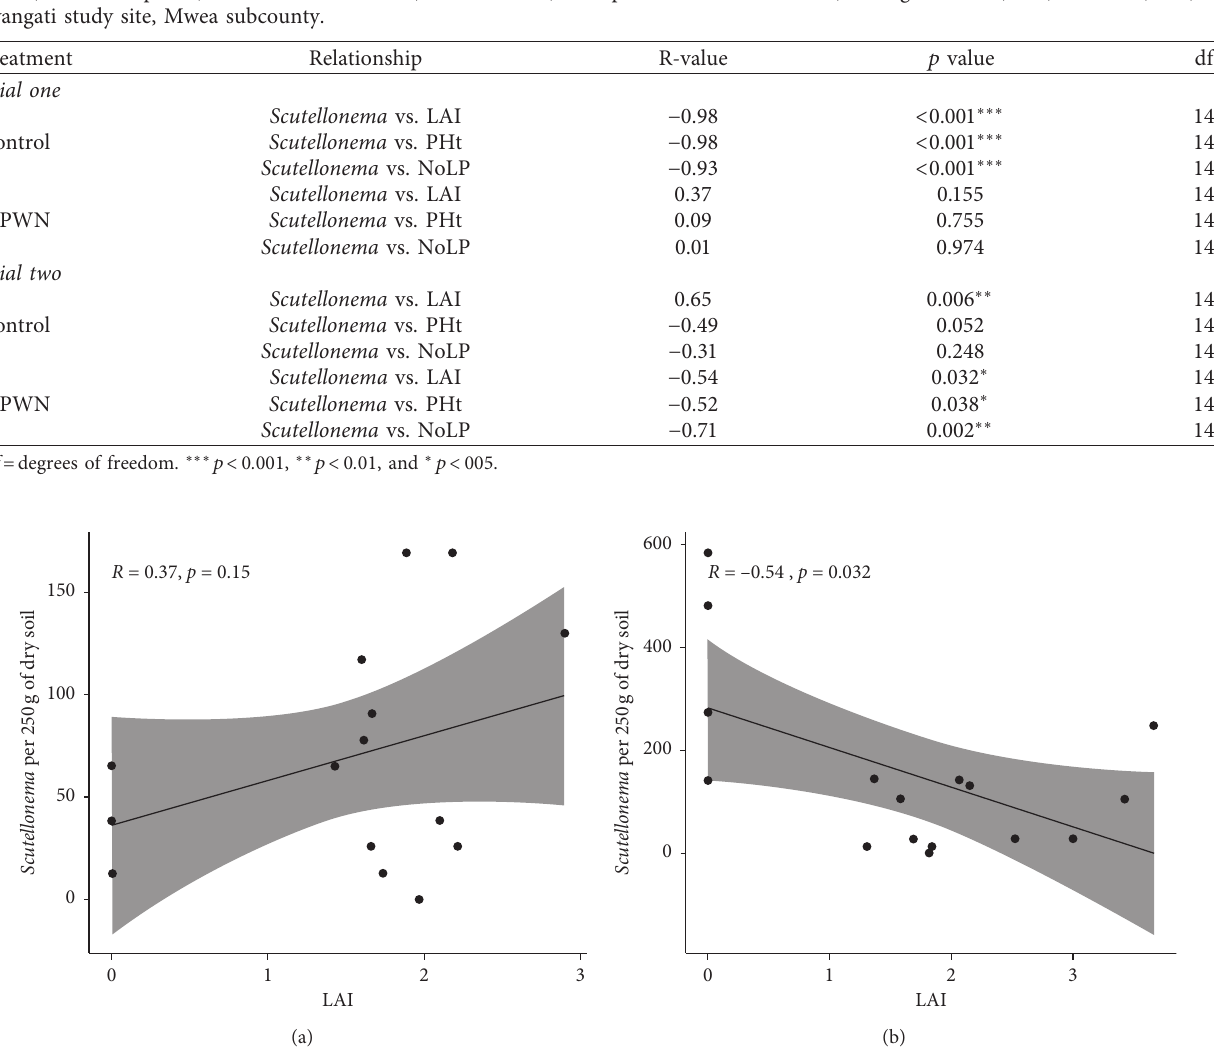
Figure 1: Correlation between leaf are index (LAI) and Scutellonema abundance during trial one in 2018 (a) and trial two in 2019 (b) in MPWN treatments. The relationship for 2018 revealed a nonsignificant positive association ( R � 0.37, p � 0 . 15), while that for 2019 revealed a negative association ( R � − 0.54, p � 0 .